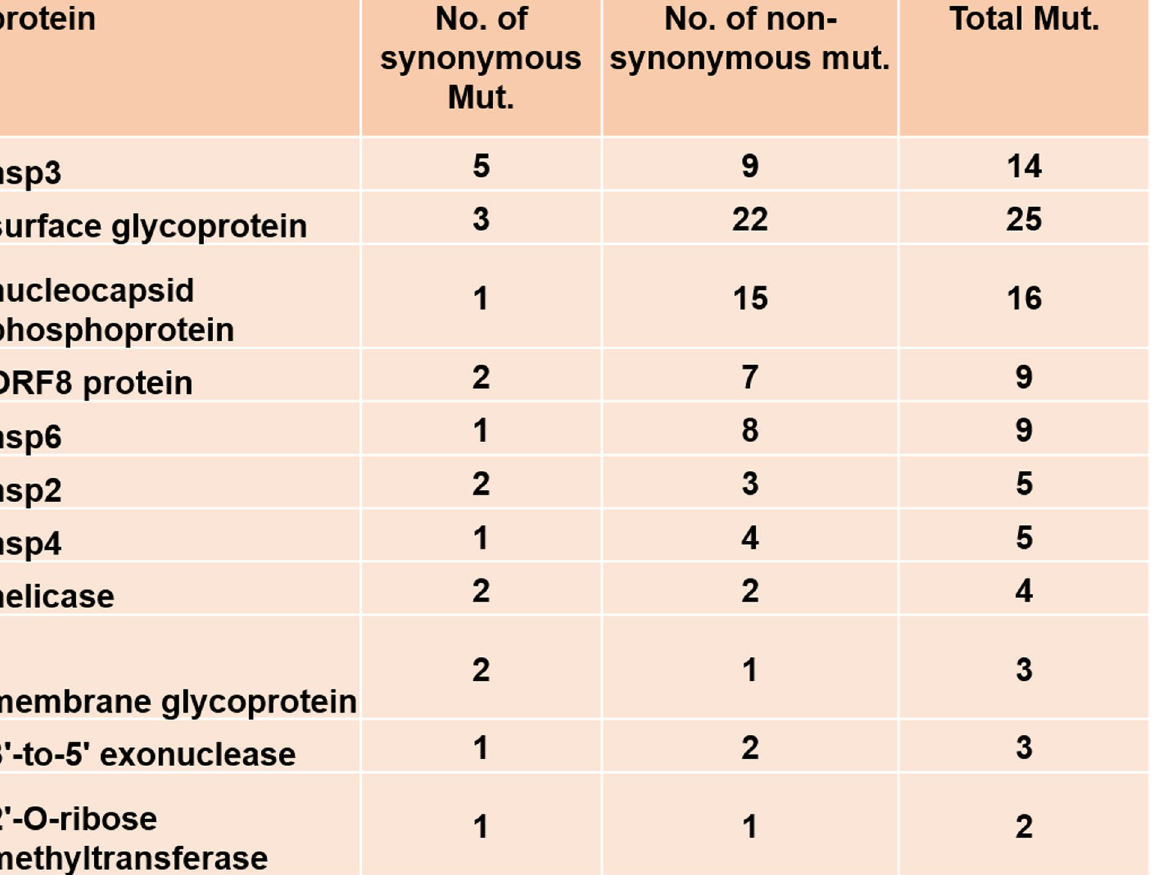
Table 3 Global distribution of 11 major mutant genes with the number of synonymous and non-synonymous mutations of severe acute respiratory syndrome coronavirus 2 (SARS-CoV-2) genome present at least in >10,000 global